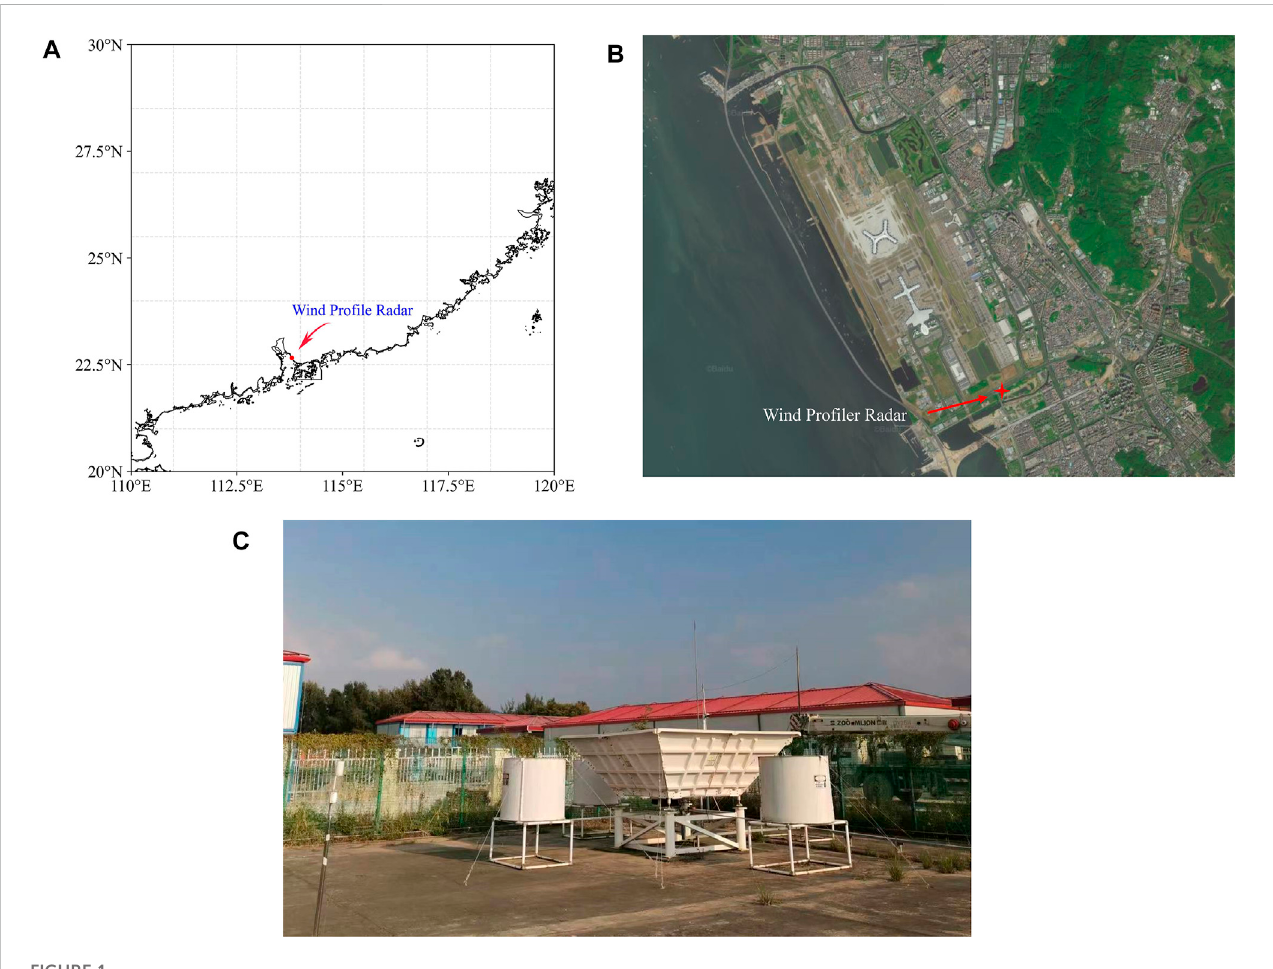
Location (A,B) and view (C) of radar wind pro fi